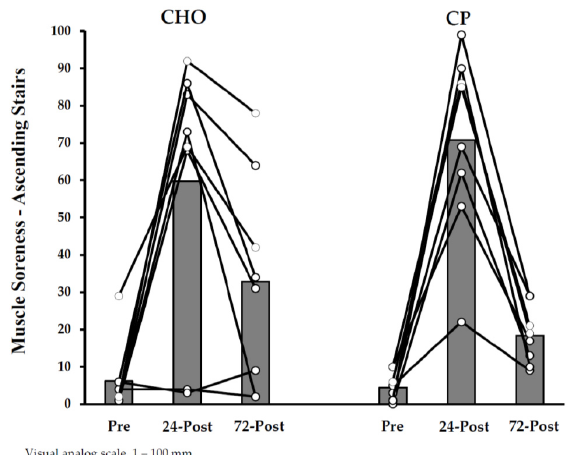
Figure 1. Muscle Soreness Ratings (Ascending Stairs) with Protein Supplementation during Exercise.